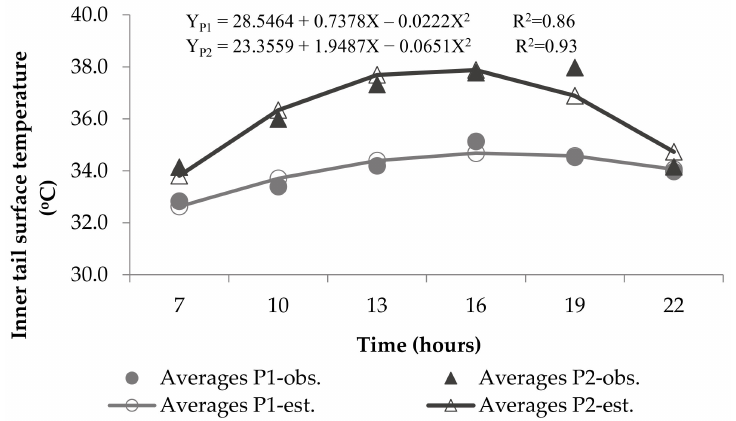
Figure 5. Regression equations between the variable tail temperature (TT) along the hours in P1 and P2 (observed values vs. predicted